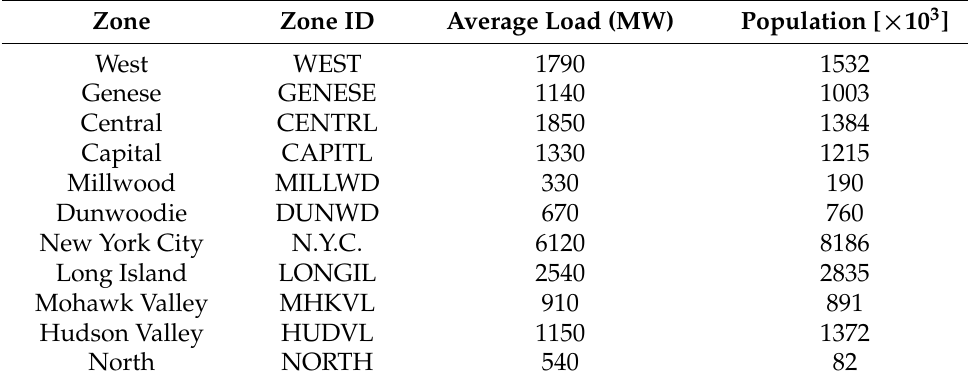
Table 1. NYISO zones’ average consumption and number of